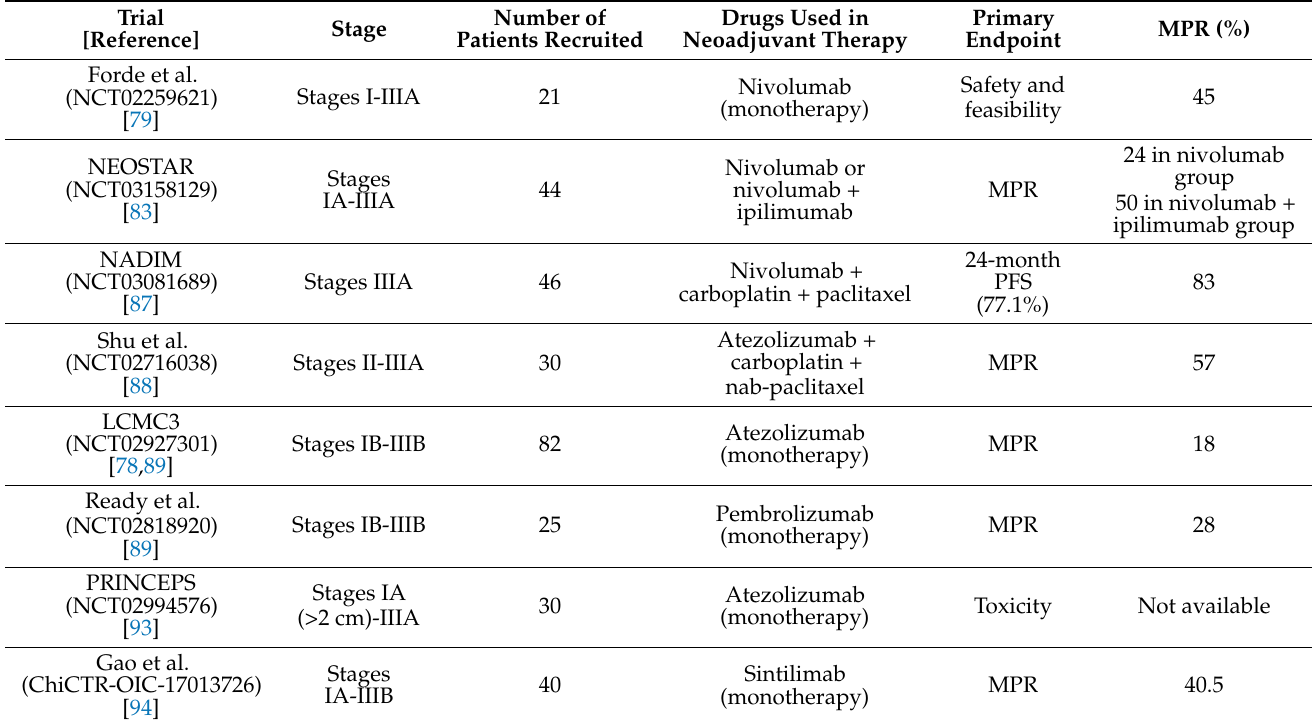
Table 2. Results of clinical trials using immunotherapy with or without chemotherapy as neoadjuvant therapy for resectable NSCLC